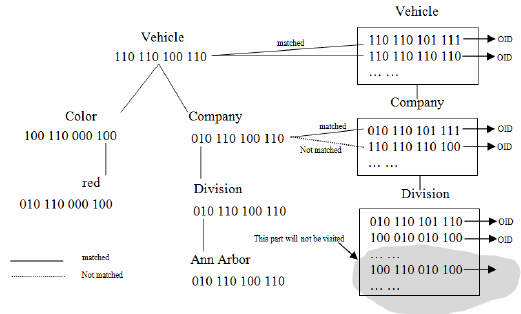
Figure 5. Illustration of query